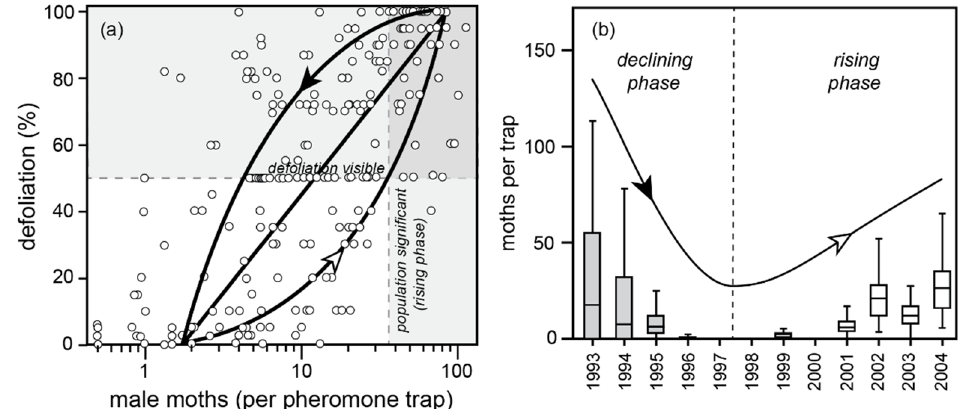
Figure 8. Cooking Lake, Alberta population and defoliation data from two partial population cycles, 1993–2004. The population phase-plane cycle in ( a ) represents the two curves one would expect from a rising population (white arrowhead; high late larval survival) versus a declining population (black arrowhead; low late larval survival). Given there is only one complete population cycle (among many plots) represented, this loop is a crude approximation, fitted by eye. Shading in ( b ) indicates years where defoliation was visible: 1993–95. Note the high spatial variation in moth densities implied in the whisker plots.